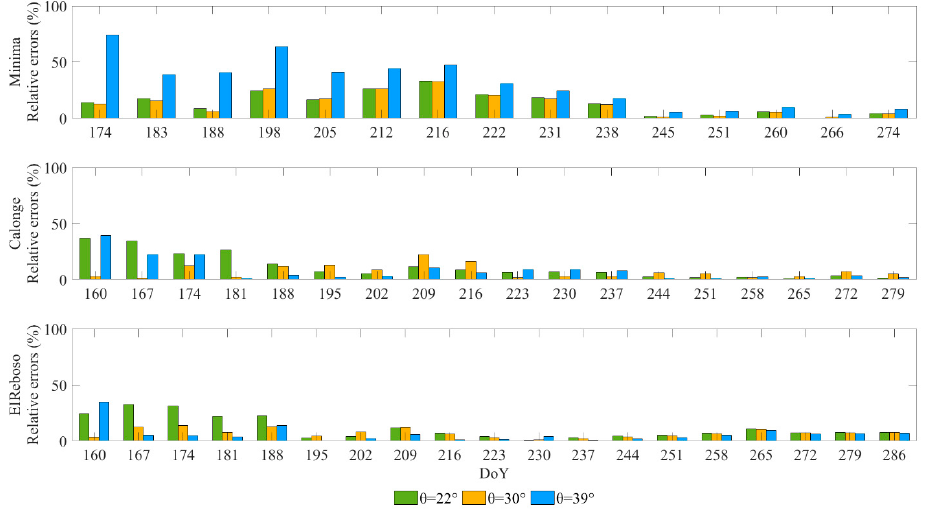
Figure 11. Relative errors of the vegetation height estimated with different incidence angles (22°, 30°, and 39°). Statistics are presented for the range of values in which the relative errors are less than 100%.